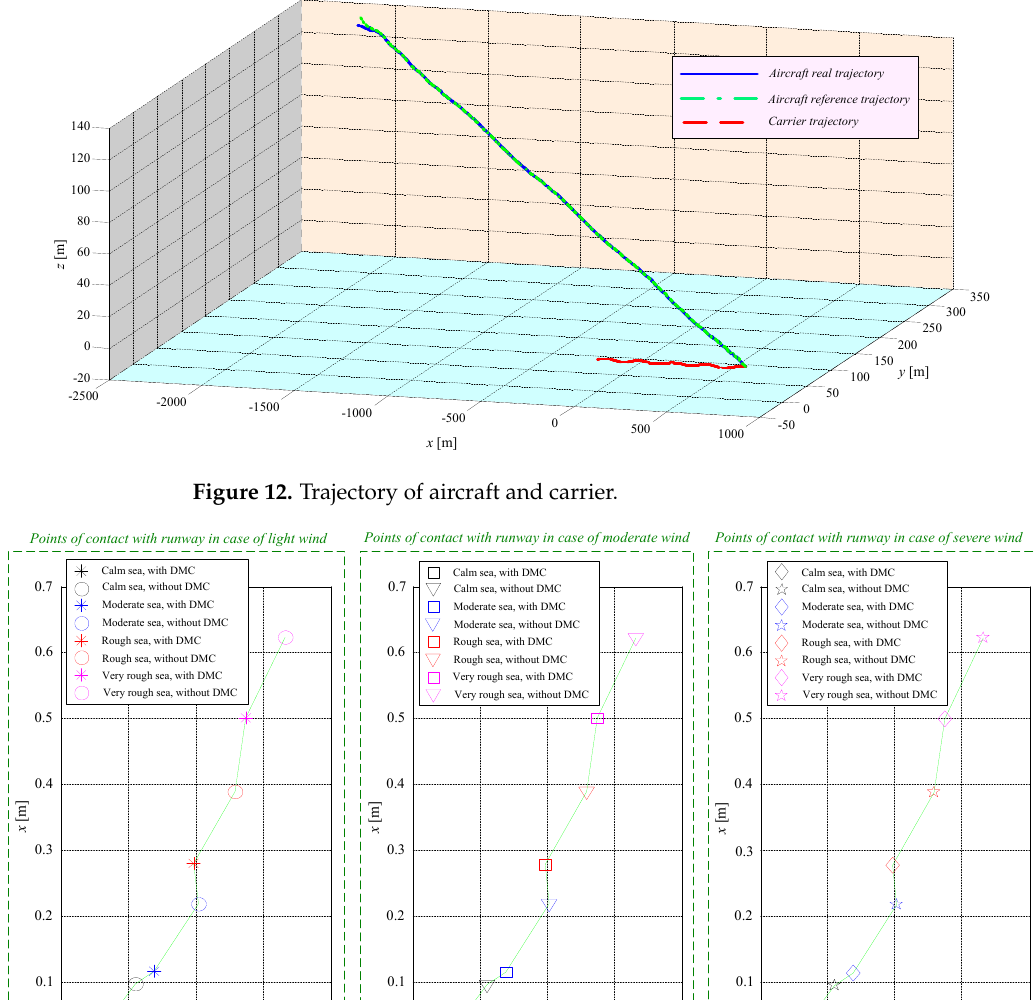
Table 1. Distribution of the touchdown points.